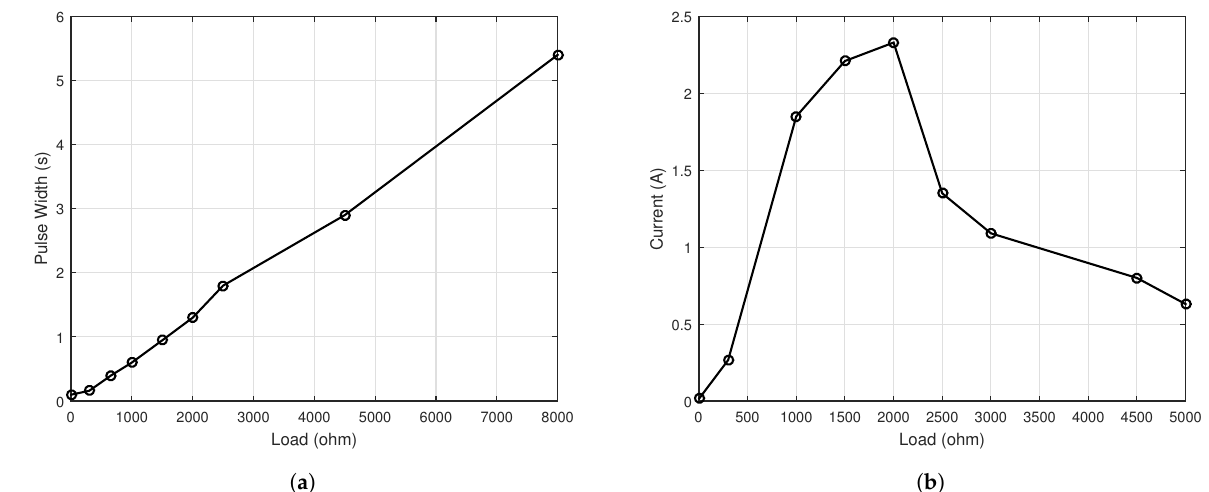
Figure 7. The relation between the pulse width, ( a ) load current and ( b ) load.